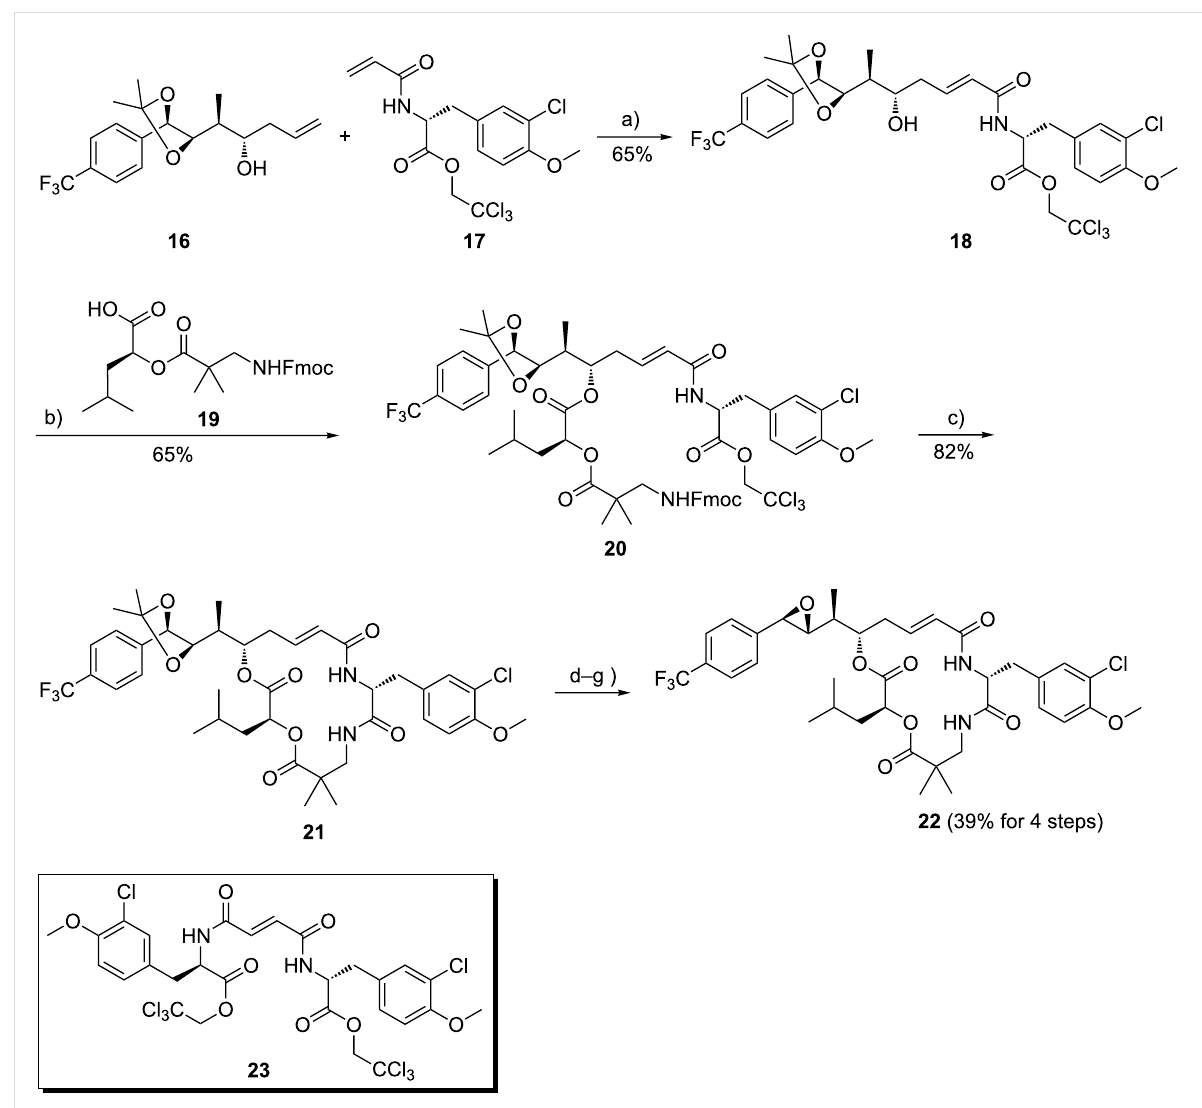
Scheme 2: Assembly of units A–D and macrocyclization, followed by diol-epoxide transformation to give the trifluoromethyl substituted analogue 22 of cryptophycin-52. Reagents and conditions: (a) Grubbs II catalyst, CH 2 Cl 2 , reflux, 16 h; (b) 19 , DMAP, NEt 3 , 2,4,6-trichlorobenzoylchloride, THF, 0 °C,